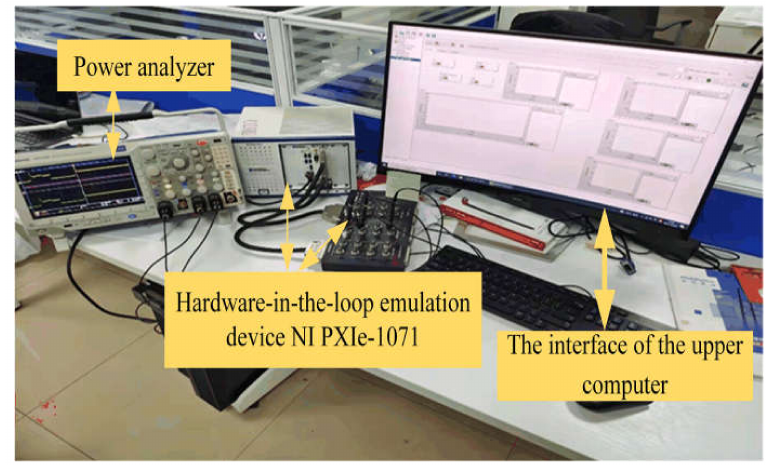
Figure 17. Hardware-in-the-loop experiment hardware configuration. Figure 24. The battery’s current, voltage, and power under load constant and radiation changes.